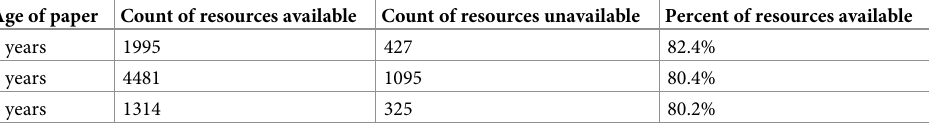
Table 2. Availability of resources by age of the associated